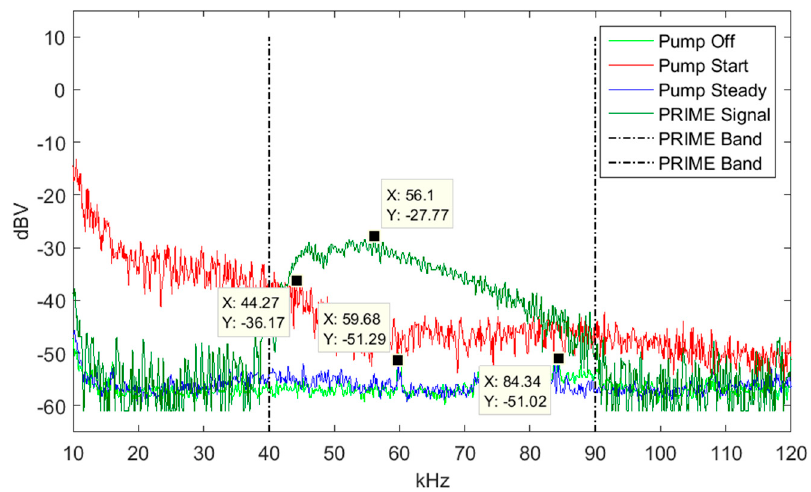
Figure 6. Spectrum recorded at the pump SM with the rest of devices disconnected.